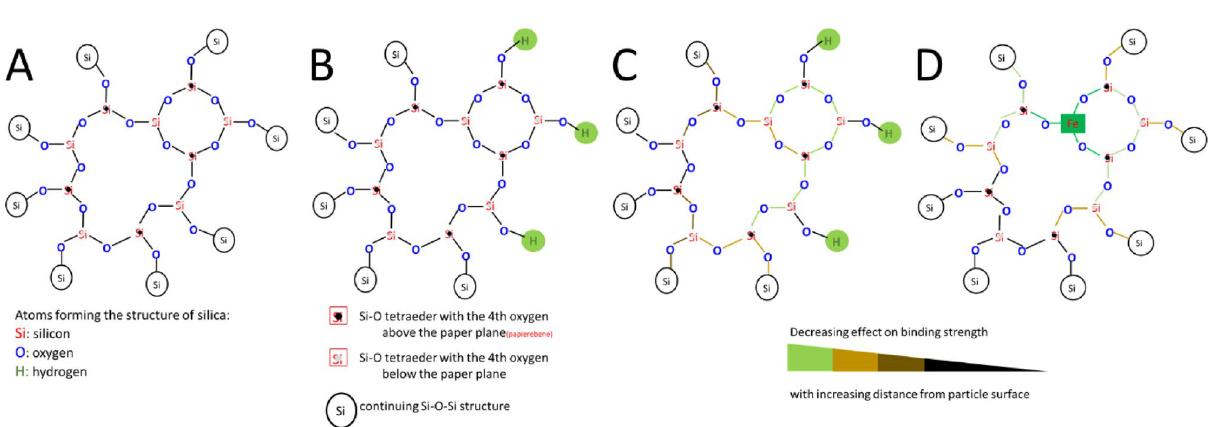
Figure 5. Schemes of Si–O–Si bonds ( A ) within the center of and ( B ) located at the surface of an amorphous silica particle. ( C ) scheme of Si–O–Si bonds near to particles surfaces with the different colors indicating the how binding strength of Si–O–Si groups is affected by the OH groups located at the particles surface and ( D ) a silica particle that contains an Fe cation including the cations effect on the binding